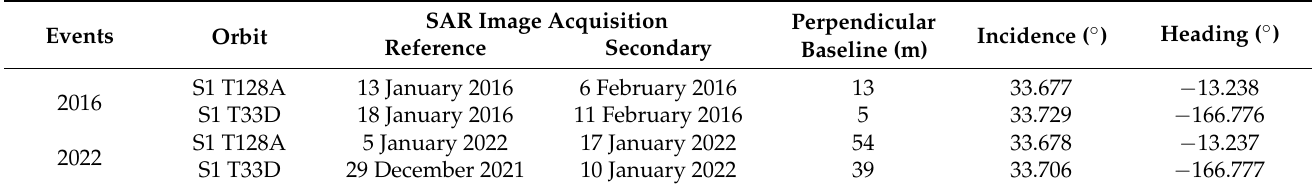
Table 2. Parameters of the SAR images for the 2016 and 2022